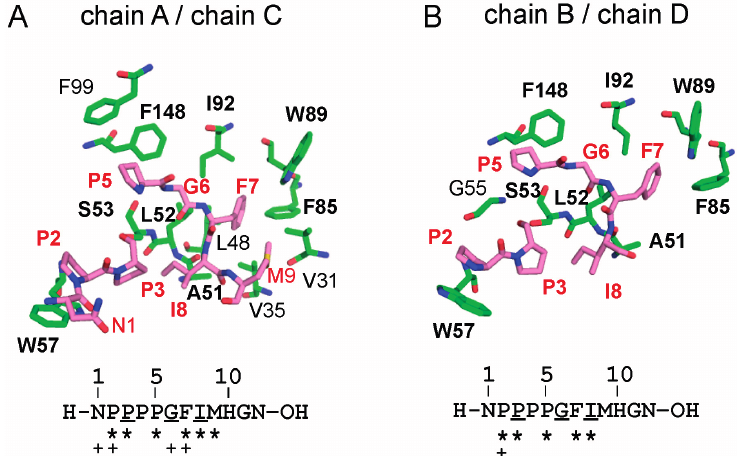
Figure 5. Interactions between ALG-2 Pocket 3 residues and Sec31A peptide. Residues involved in interactions between ALG-2 and the Sec31A peptide ( A , chains A and C; B , chains B and D) are shown in stick models (ALG-2, green; Sec31A peptide, pink). Nitrogen and oxygen atoms are shown in blue and red, respectively. ALG-2 residues commonly interacting with the peptides in both chains A and C are indicated in bold face. Asterisks and plus symbols indicate side chain and main chain carbon atoms of the Sec31A peptide residues that interact with side chain atoms of ALG-2 molecules, respectively. Underlines indicate residues involved in hydrogen